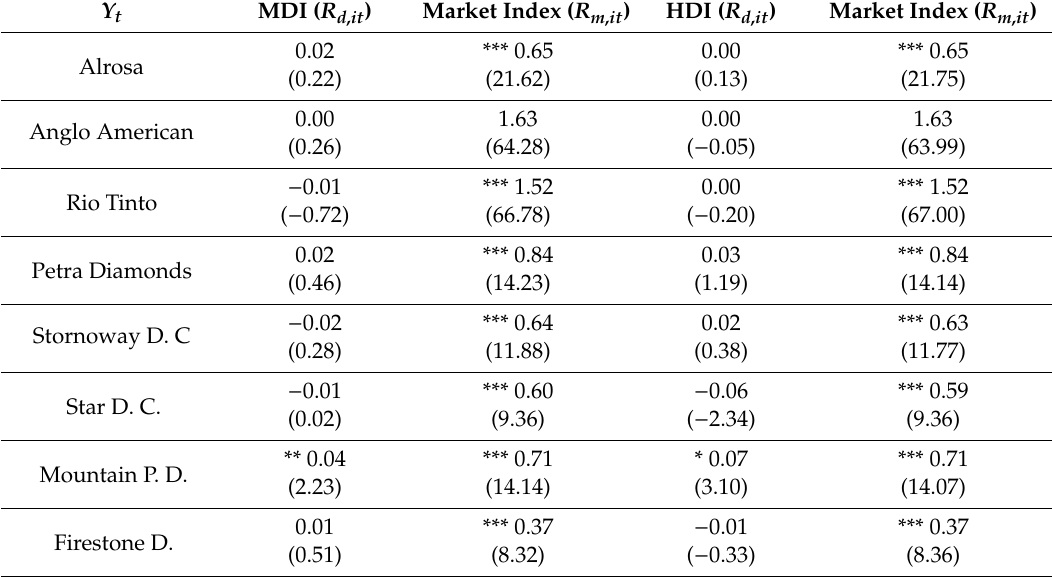
Table 10. GARCH regression coe ffi cients from the mean